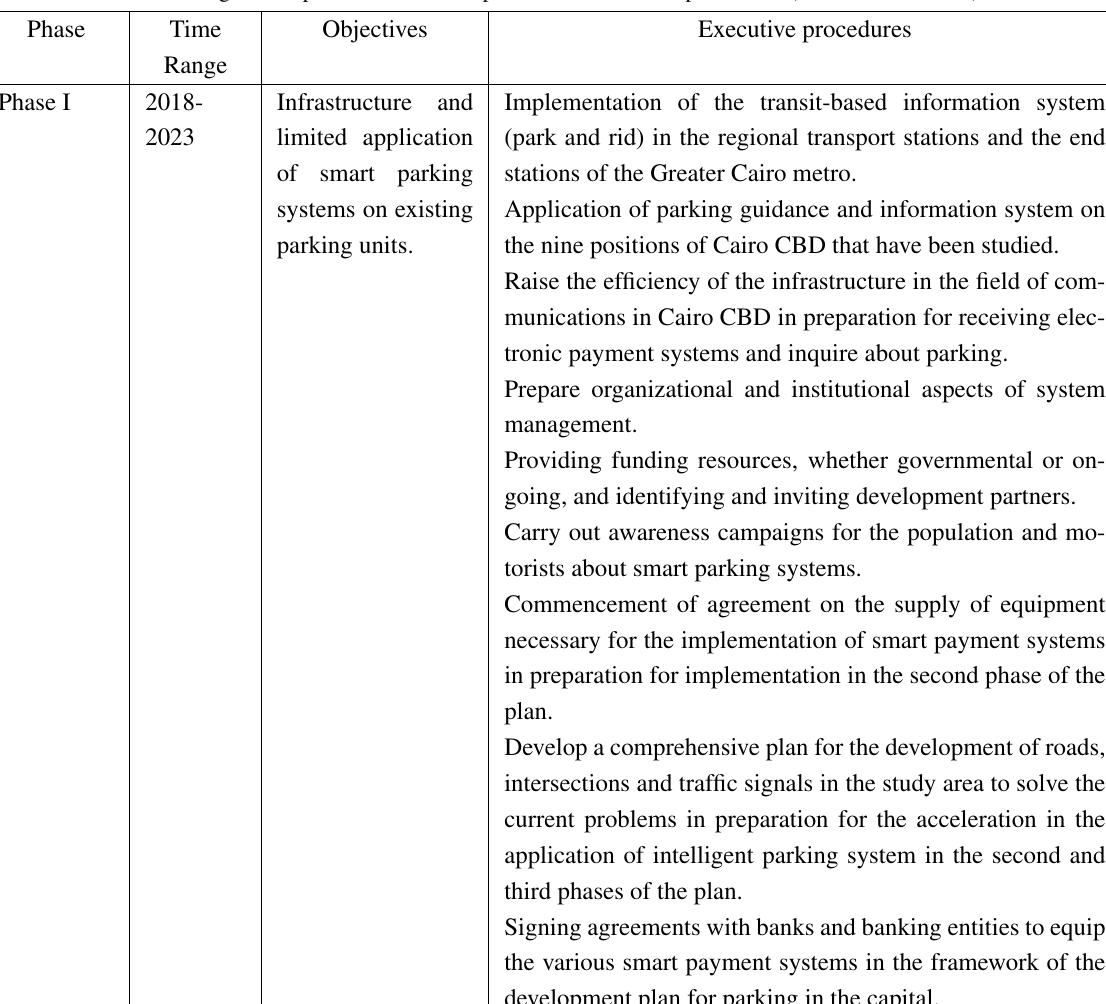
Table 8. Stages of implementation of the plan and its Executive procedures (Source: